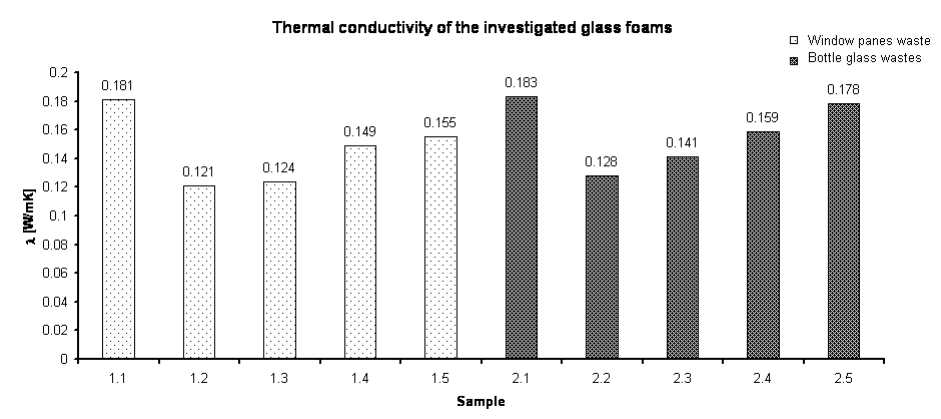
Figure 5. The thermal conductivities of the studied glass foams.